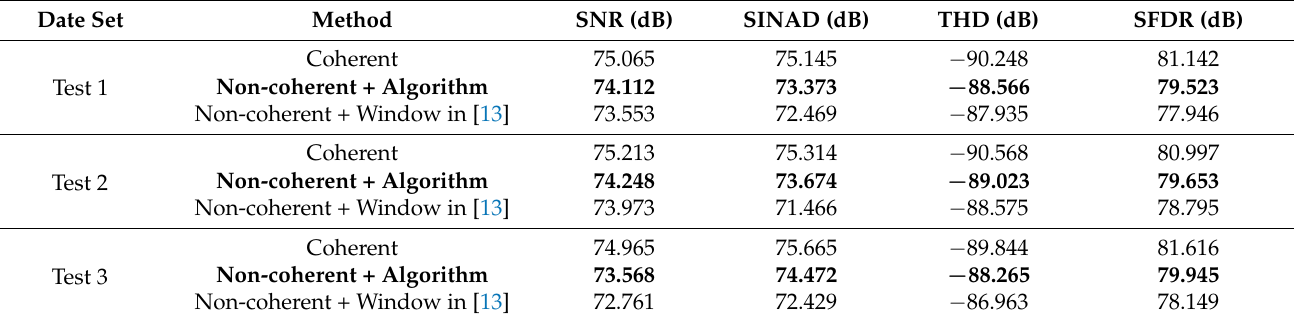
Table 2. Dynamic test results.